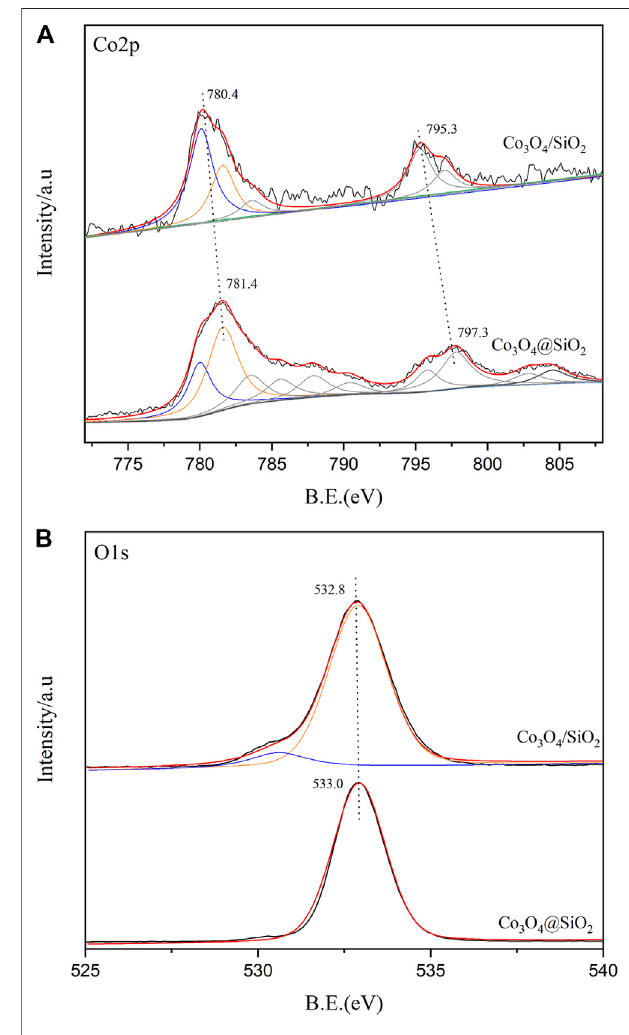
FIGURE 2 | XPS survey spectra of Co 3 O 4 @SiO 2 and 25Co 3 O 4 /SiO 2